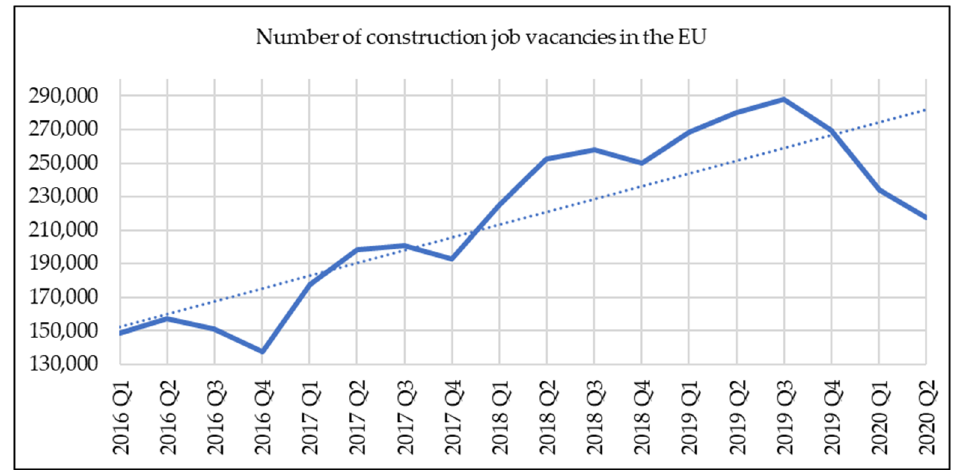
Figure 2. Quarterly trend of construction job vacancies (in thousands) in the EU (the figure is structured by authors upon open-source data collected from [71]).